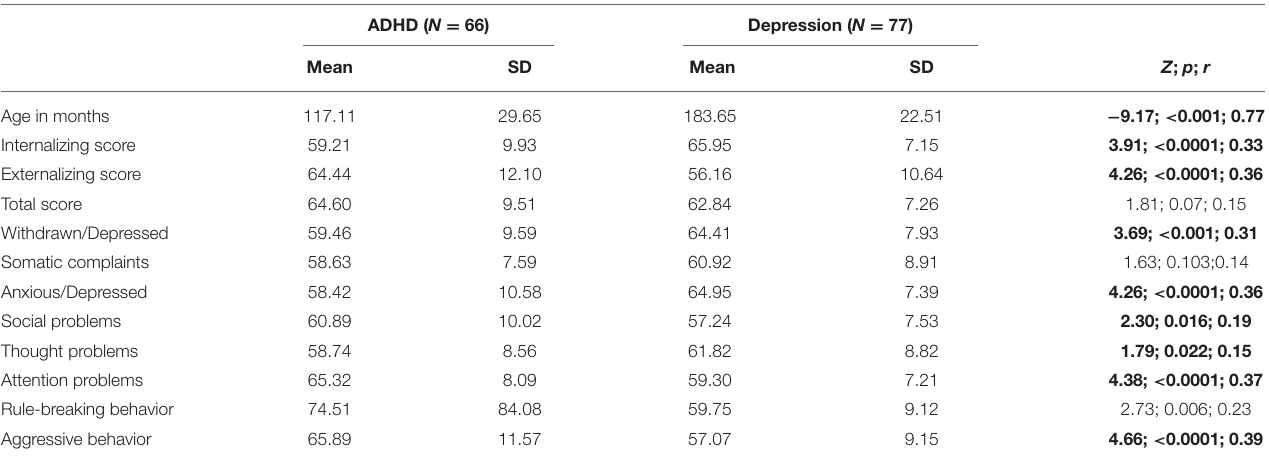
TABLE 2 | Behavioral